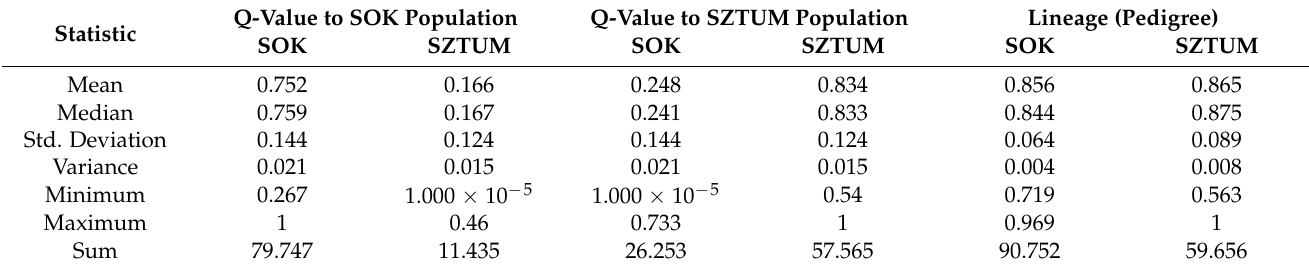
Table 5. Basic statistics for Q-value from Admixture software and linage data from